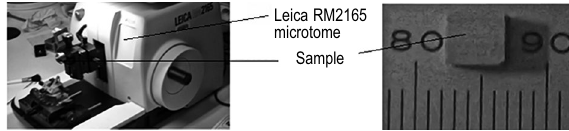
Fig. 5. Sample cut with Leica RM2165 microtome